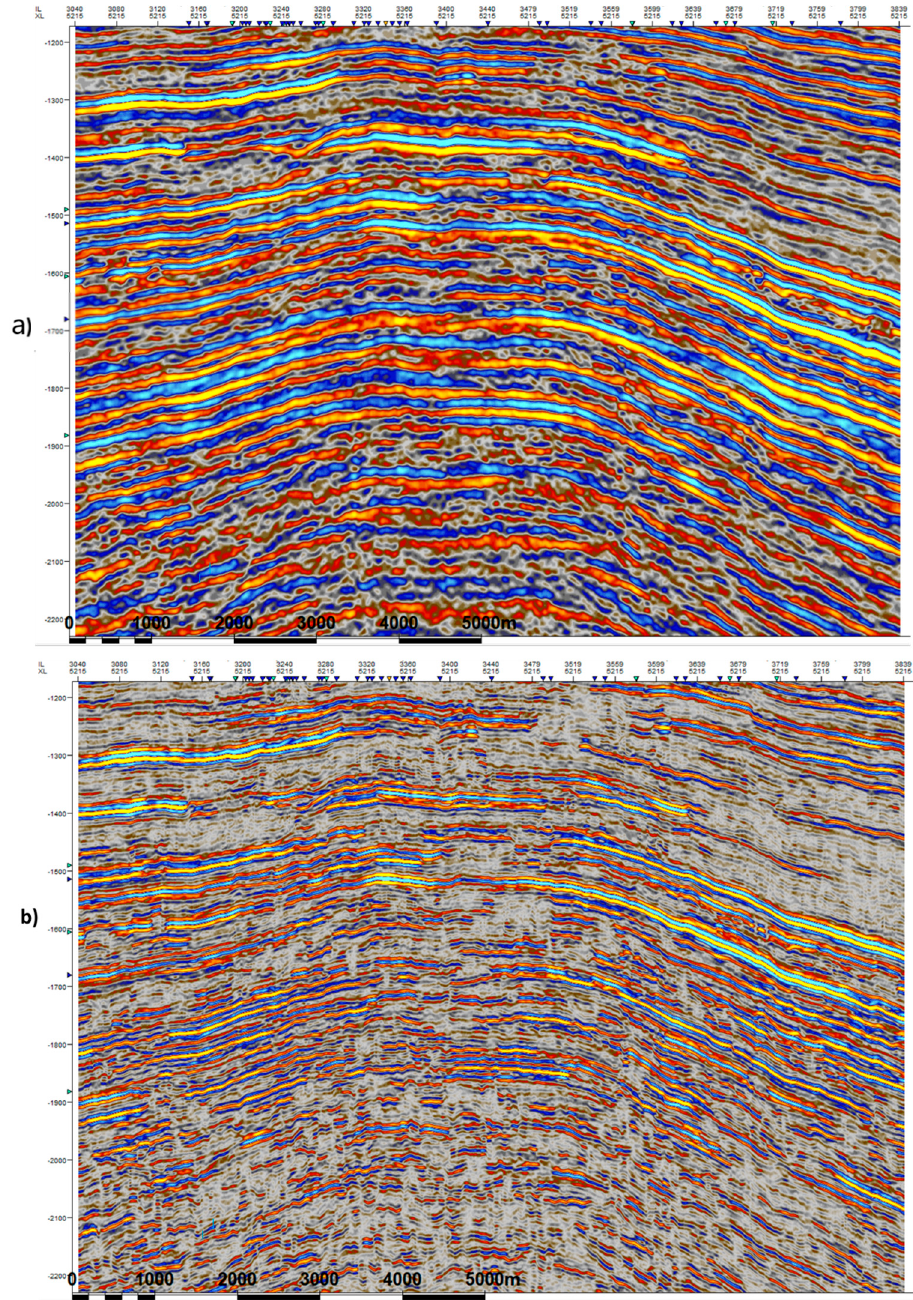
Figure 19. A section of the original seismic volume at dip line—5215 ( a ) and a section through the improved seismic volume at dip line—5215 ( b ). The resolution of the enhanced volume is visibly improved and captures more geologic details when compared to the original data.